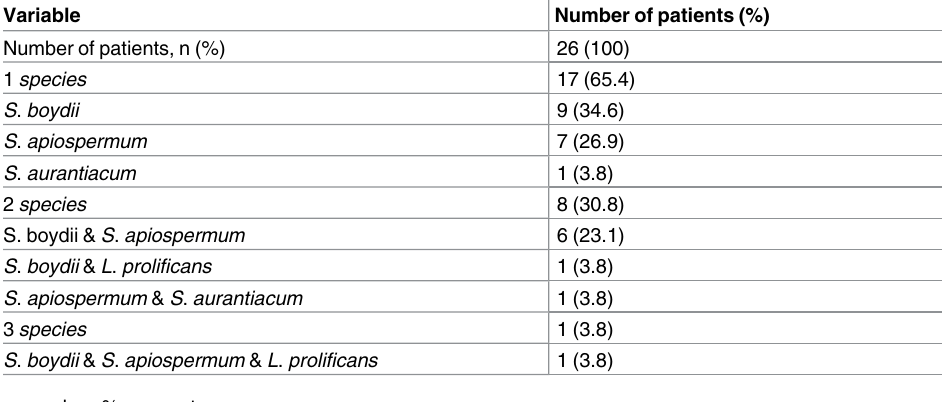
Table 2. Evidence of isolated Sac-Lp species per patient. Variable Number of patients